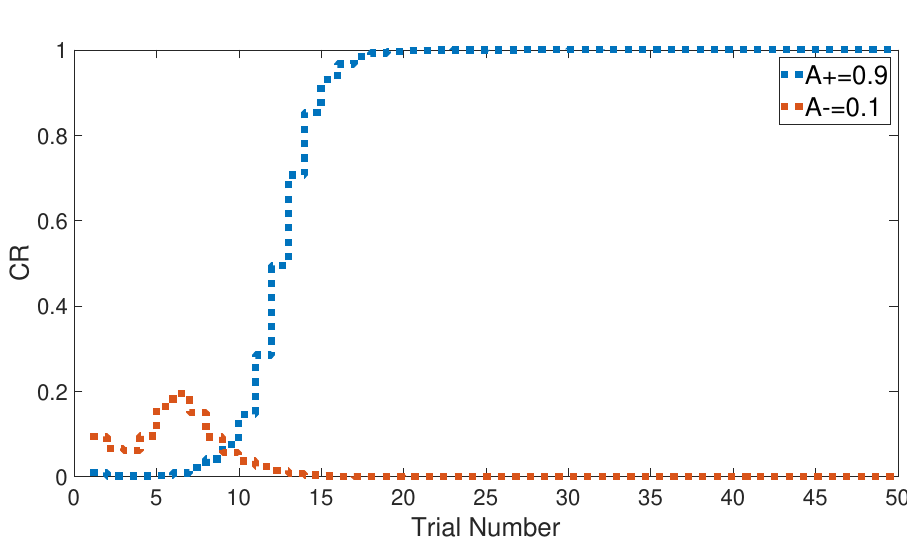
Figure 18. Easy transfer task for the lesioned